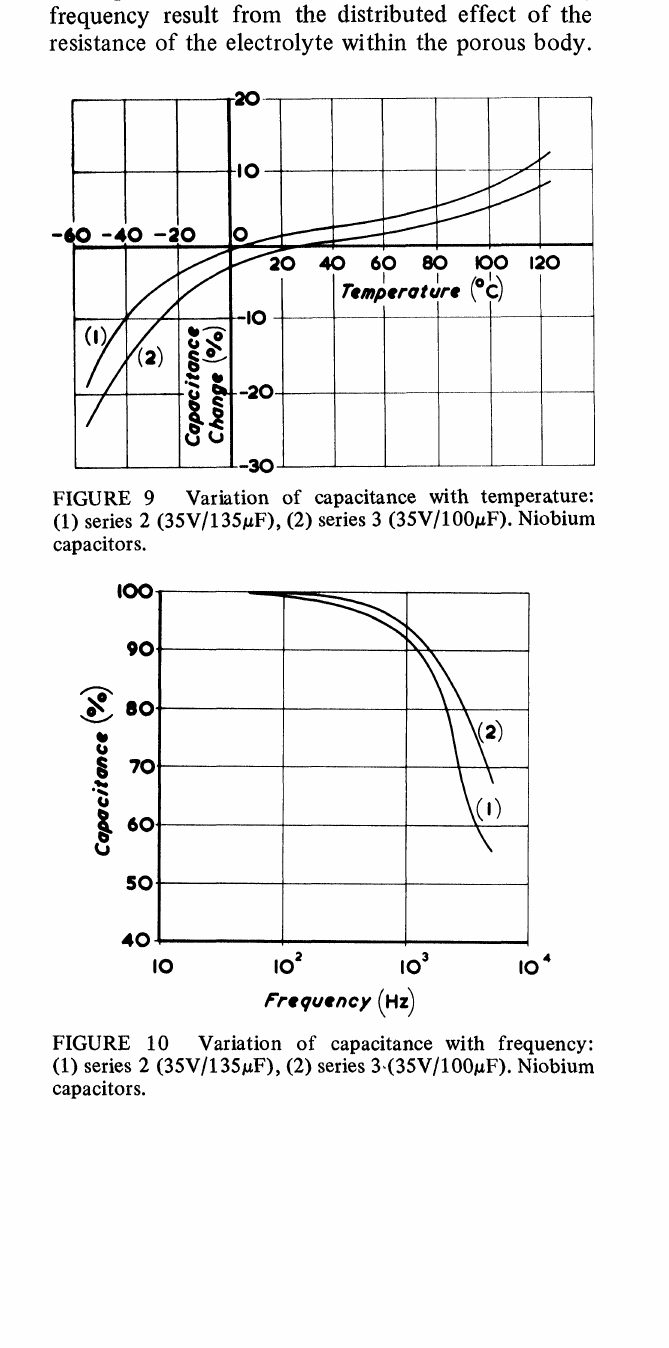
Variation of leakage current with temperature: (1) series 2 (35V/135#F), (2) series 3 (35V/100#F). Niobium capacitors.